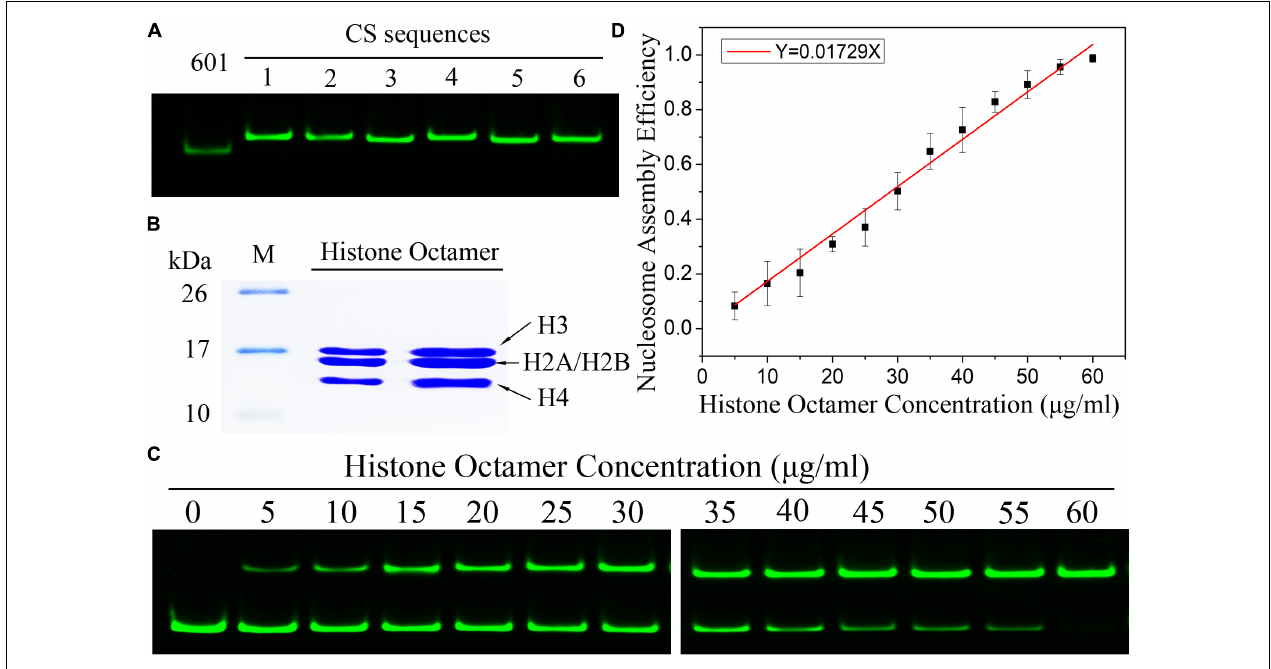
FIGURE 1 | The efficiency of nucleosome assembly on the Widom 601 sequence in vitro by salt dialysis is dependent on histone concentration. (A) Preparation of Widom 601 DNAs and CS DNAs. The Cy3-labeled DNA sequences were detected by native-PAGE. (B) Preparation of histone octamer. The reconstituted canonical histone octamer was analyzed by SDS-PAGE. (C) Detection results of nucleosome assembly in vitro . The reconstituted nucleosomes with different histone octamers were analyzed by native PAGE. In each lane of the gel, the top band is nucleosome DNAs, and the bottom band is free DNAs. (D) The relation curves of nucleosome assembly efficiency vs. histone octamer concentration for the Widom 601 sequence. Nucleosome assembly efficiency was calculated by the ratio of nucleosome DNAs to total DNAs from panel (C) for each reconstituted sample. For each sample, five independent repeats were